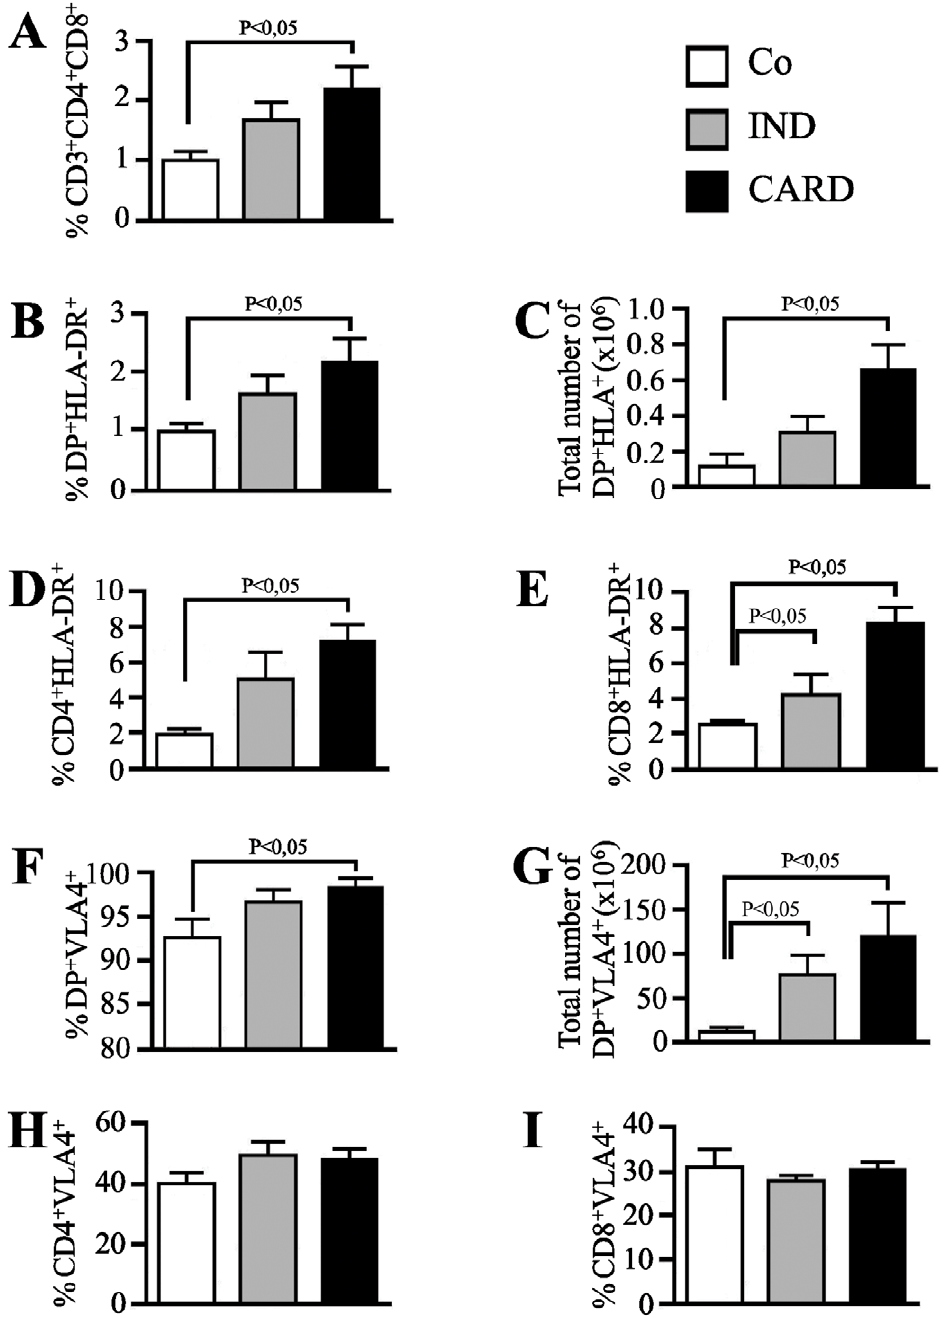
Figure 7. Frequency and phenotype of peripheral blood CD4 + CD8 + T cell subset from chronic chagasic patients. Peripheral whole blood from non-infected individuals (NI), patients at the indeterminate (IND) and cardiac (CARD) forms of Chagas disease were analyzed by four-color flow cytometry for expression of CD3, CD4, CD8, HLA-DR and VLA-4 markers (n=15 individuals per group). (a) The percentages of CD4 + CD8 + cells on CD3 + T lymphocytes are indicated for each histogram. The frequency (b) and total number (c) of activated DP T cells, frequencies of (d) single- positive CD4 T cells and (e) CD8 T cells are shown by assessing the expression of HLA-DR. The frequency (f) and total number (g) of activated DP T cells, frequencies of (h) single-positive CD4 T cells and (i) CD8 T cells are shown by assessing the expression of VLA-4. The differences between the groups were considered significant at p less than 0.05 and are represented by p , 0.05.